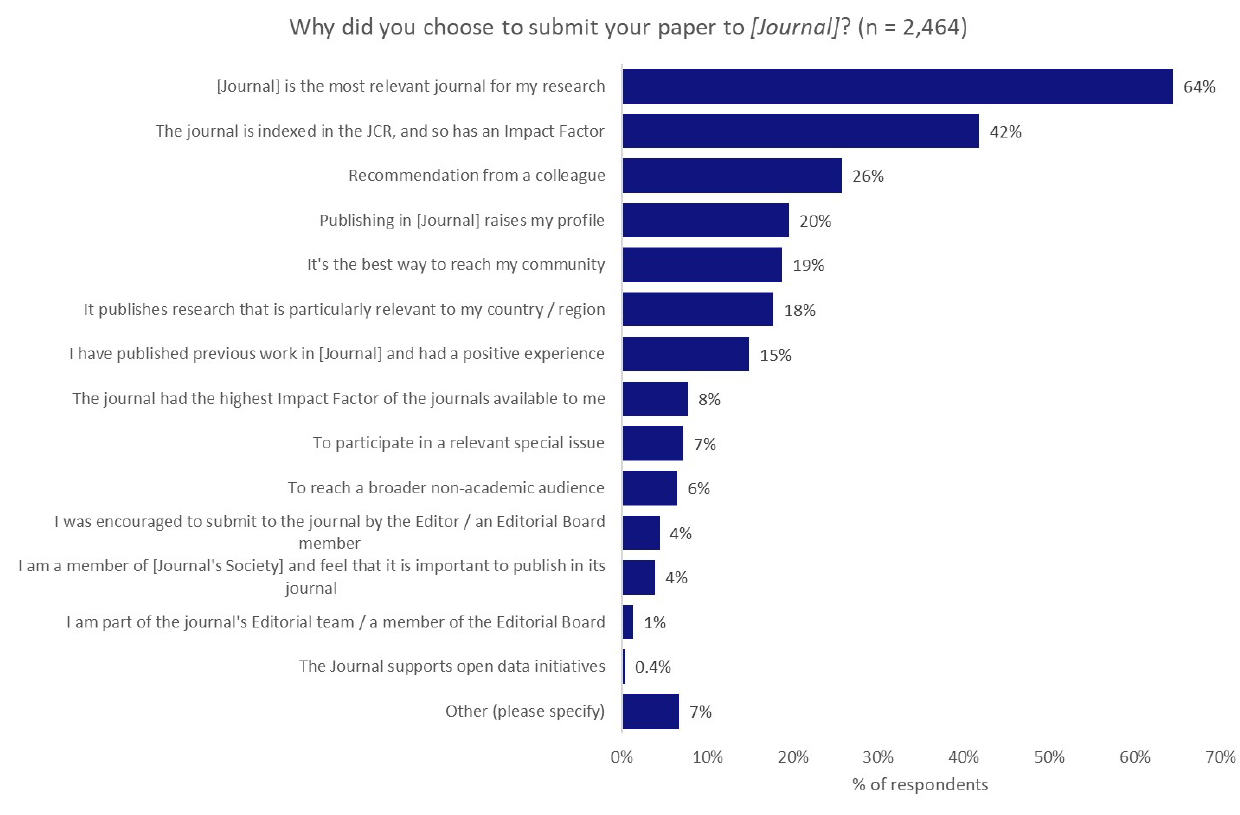
Figure 6. Motivating factors for the choice of journal.